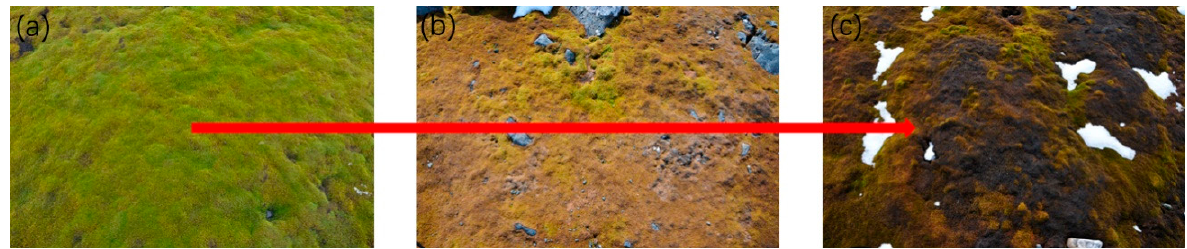
Figure 7. Photos of ( a ) healthy mosses, green, ( b ) stressed mosses, red-brown, and ( c ) moribund mosses, grey-black, indicating total loss of photosynthetic pigments.